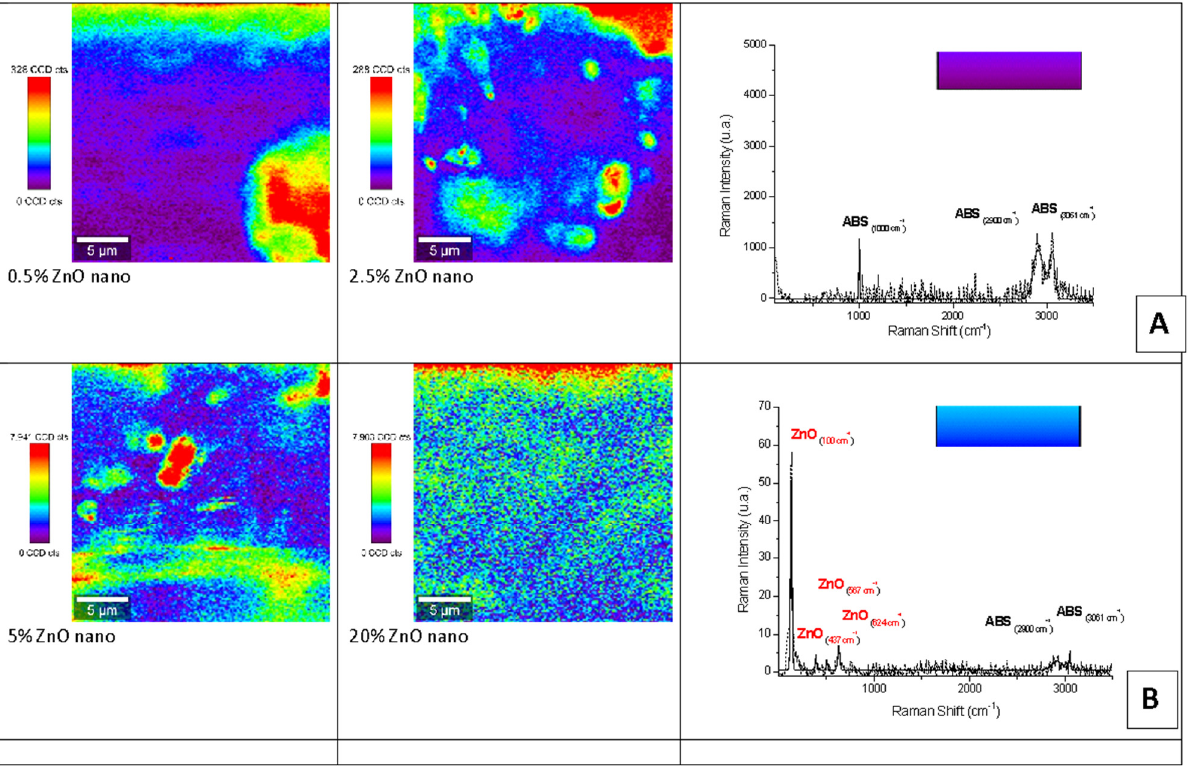
Figure 7. Raman mapping and spectra of nano-ZnO-ABS printed composite materials. ( A ) Example of Raman spectrum corresponding to mauve-blue dark color regions in the maps; ( B ) example of a Raman spectrum corresponding to blue color regions in the maps.